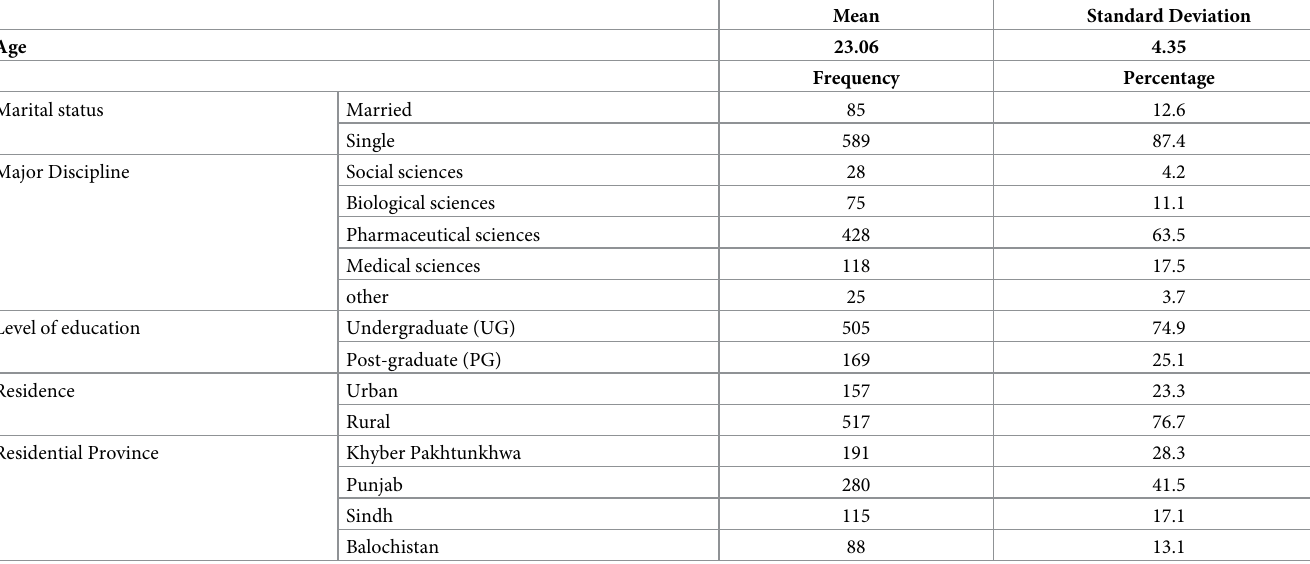
Table 1. Demographic characteristics of the participants.